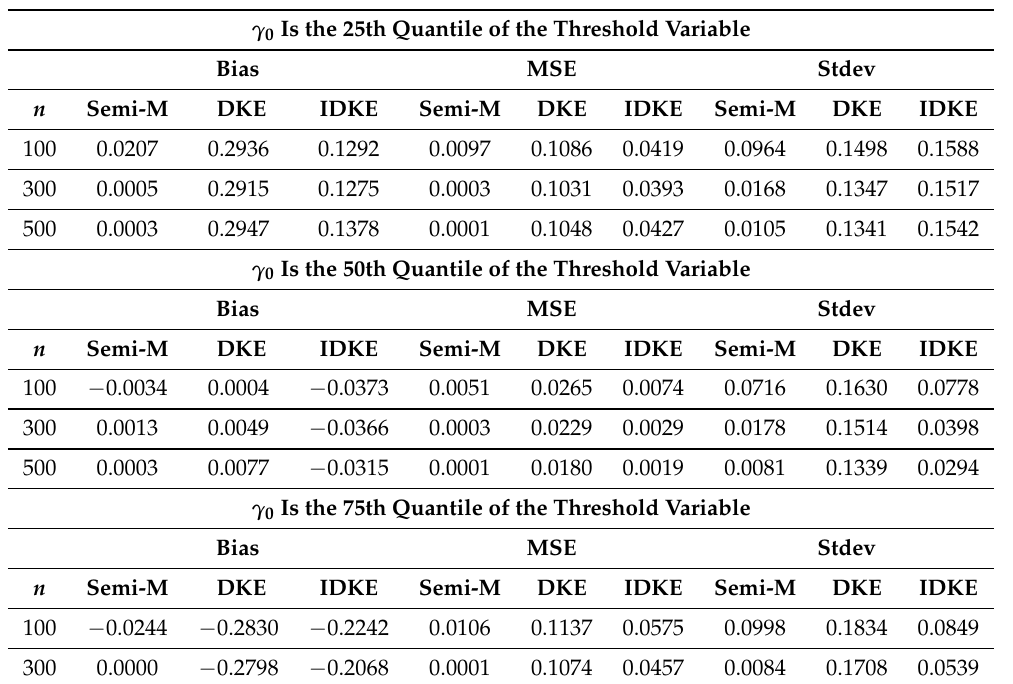
Table 7. Simulation results of nonparametric threshold estimators, DGP 7.